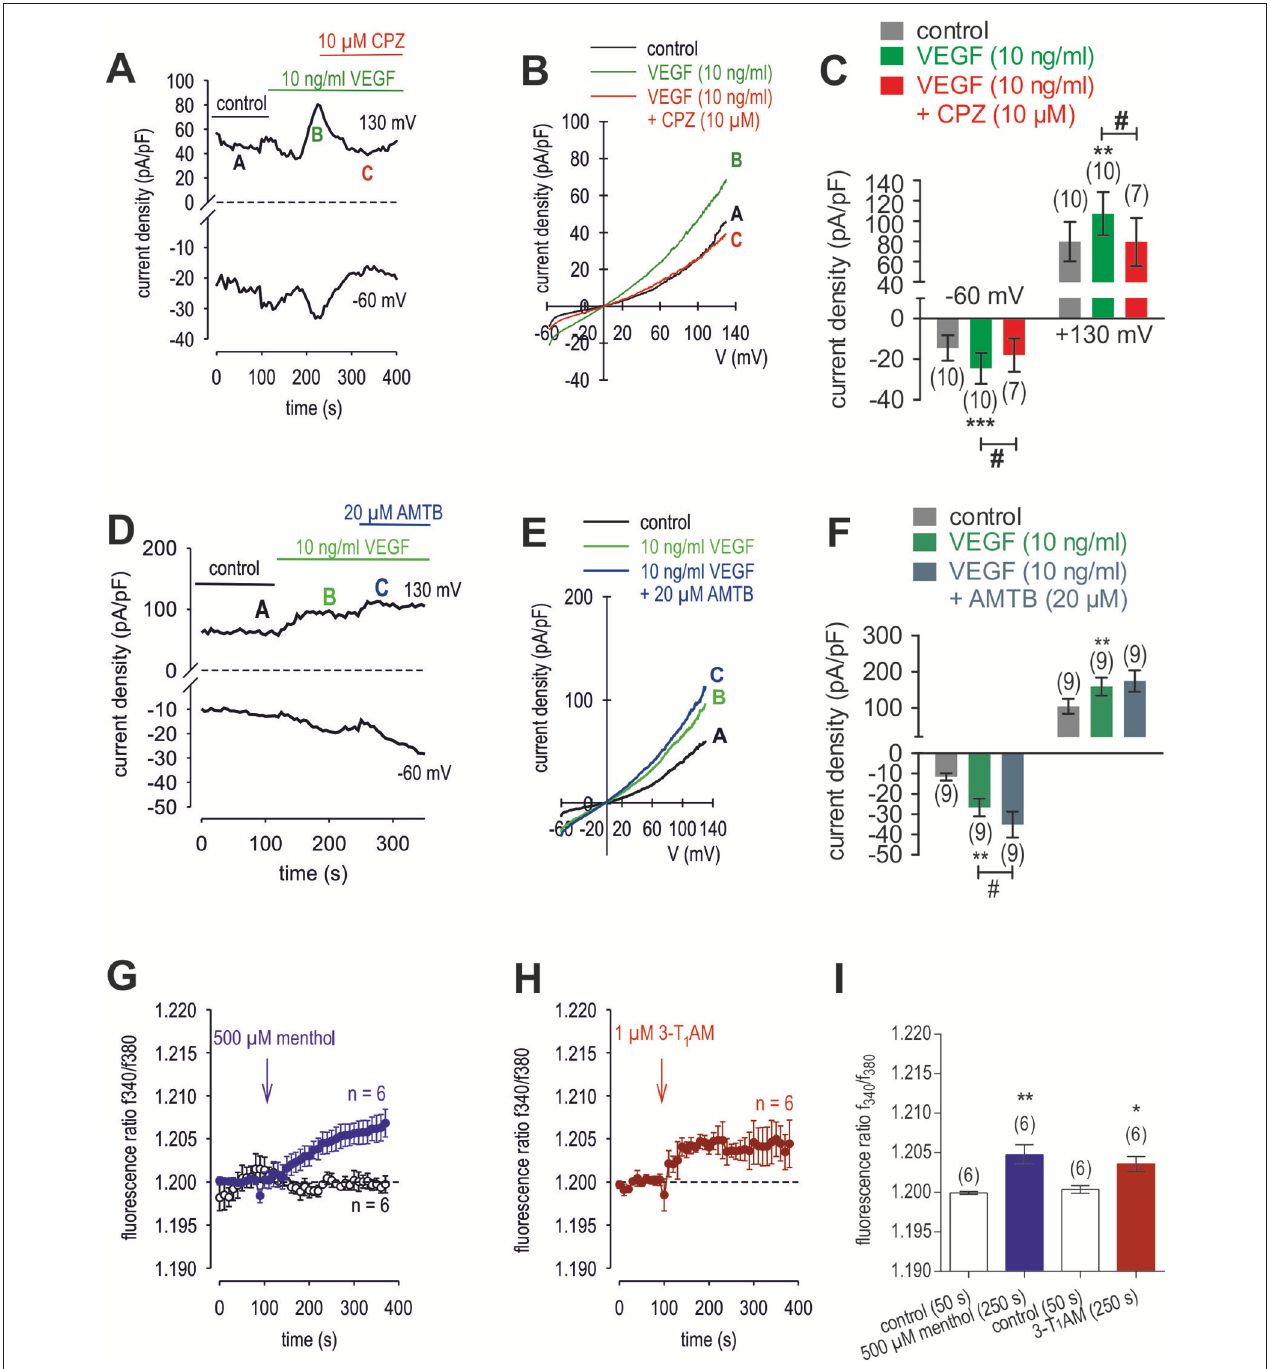
FIGURE 11 | Effect of VEGF, menthol and 3-T 1 AM on Ca 2 + regulation in HCK. (A) Time course recording showing the current increases induced by 10ng/ml VEGF and current density levels after adding CPZ (10 µ M). There was a delayed increase in the whole-cell currents. (B) Original traces of VEGF-induced current responses to voltage ramps. Current densities are shown before application (labeled as A), during application of VEGF (labeled as B), and after addition of CPZ (labeled as C). Current densities as function of voltage were derived from the traces shown in panel A. Notably, VEGF-induced in- and outward currents declined in the presence of CPZ. (C) Summary of the experiments with VEGF and CPZ. The asterisks (*) indicate statistically significant differences of VEGF-induced increases of in- and outward currents ( n = 10; p < 0.01 at the minimum; paired tested). The hashtag (#) denotes a statistically significant difference in the whole-cell inward currents with and